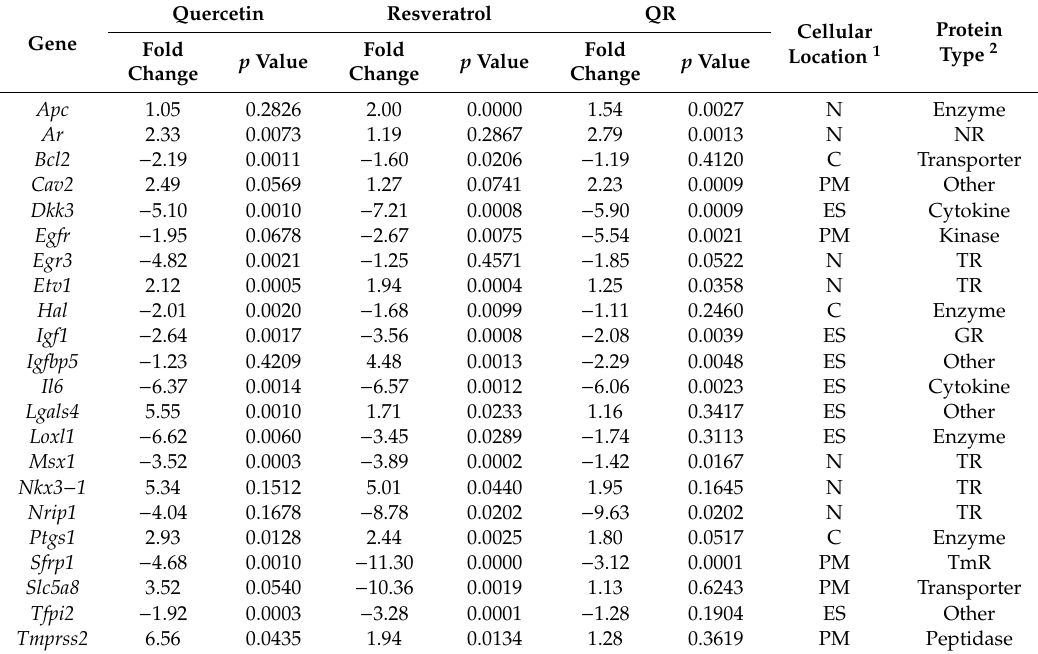
Table 1. Significantly altered genes in response to quercetin and / or resveratrol treatments in TRAMP mice. Fold change is relative to control tissues and all values are normalized to Actb , Gapdh , Gusb , and Hsp90ab1 reference